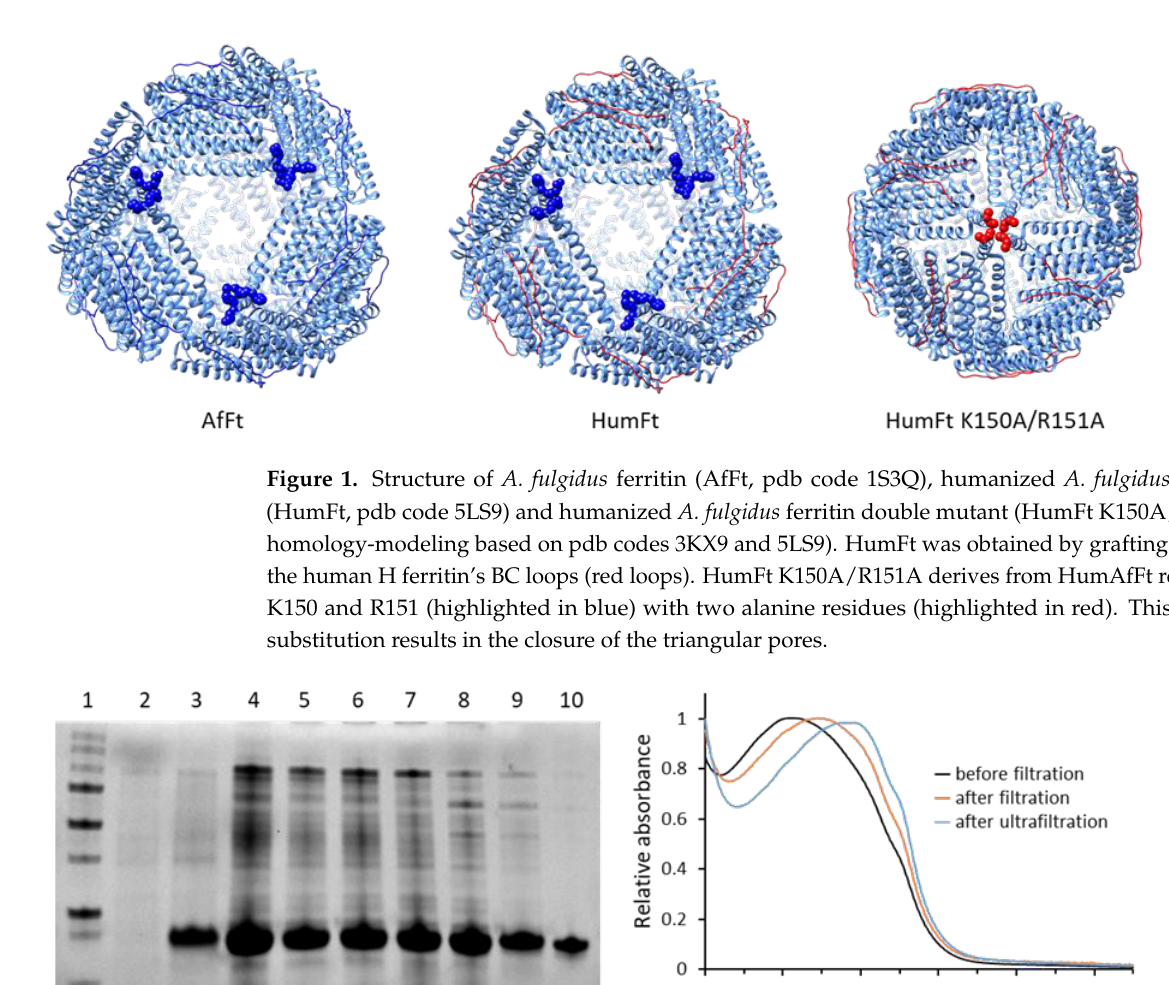
Figure 1. Structure of A. fulgidus ferritin (AfFt, pdb code 1S3Q), humanized A. fulgidus ferritin (HumFt, pdb code 5LS9) and humanized A. fulgidus ferritin double mutant (HumFt K150A/R151A, homology-modeling based on pdb codes 3KX9 and 5LS9). HumFt was obtained by grafting on AfFt the human H ferritin’s BC lo ops (red loops). HumFt K150A/R151A derives from HumAfFt replacing K150 and R151 (highlighted in blue) with two alanine residues (highlighted in red). This double substitution results in the closure of the triangular pores.